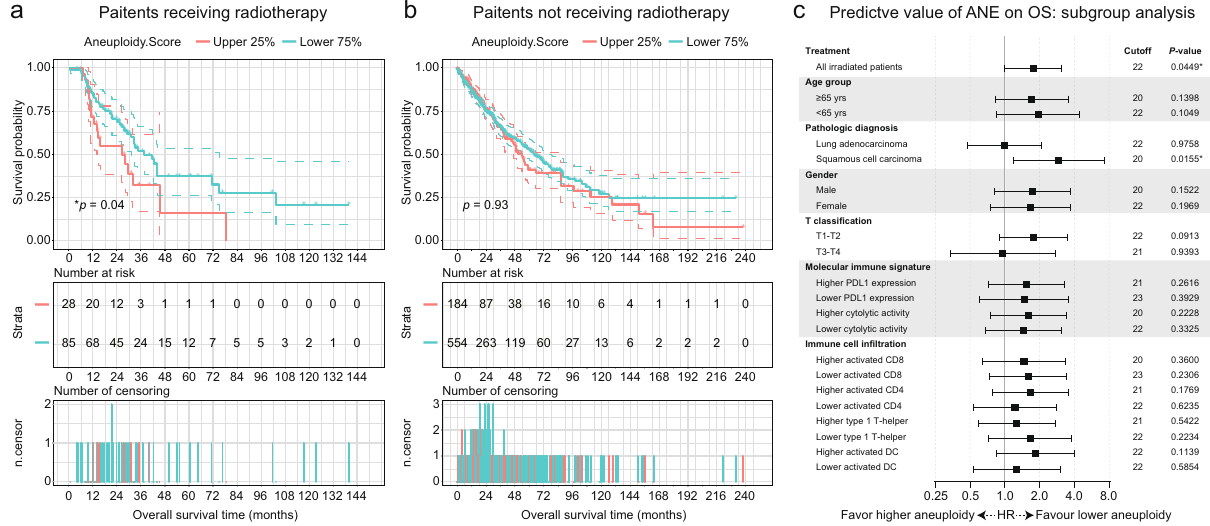
Fig. 2 Overall survival according to the presence of high or low tumor aneuploidy score within tumor. a, b Kaplan-Meier survival curves of OS (upper panel), table of number of risk (middle panel), and number of censoring (lower panel) according to the different aneuploidy (ANE) scores for patients with ( a ) or without ( b ) radiotherapies. The hazard ratio (HR) was estimated by means of Log-rank test. 95% CI for HR was shown as colored dashed line. Red line, patients with higher ANE score; blue line, patients with lower ANE score. c Forest plot of ANE score on OS for radiated patients, strati fi ed by demographics, molecular immune signatures, and immune cell in fi ltration. HRs comparing OS within each subgroup were showed in log2 scales. Bars represent the 95% CI. The upper 25% cutoff ANE score for each subgroup as well as the two-sided Cox proportional regression p -value were displayed. The molecular immune signature and immune cell in fi ltration was grouped based on their median